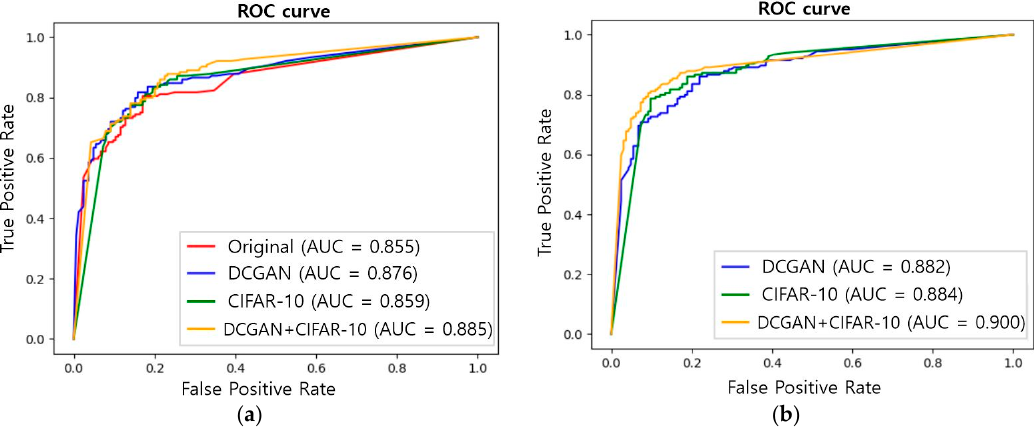
Figure 10. Gastric cancer classification model performance based on the ROC curve: ( a ) models with no image quality measurement method and ( b ) models with the image quality measurement method.